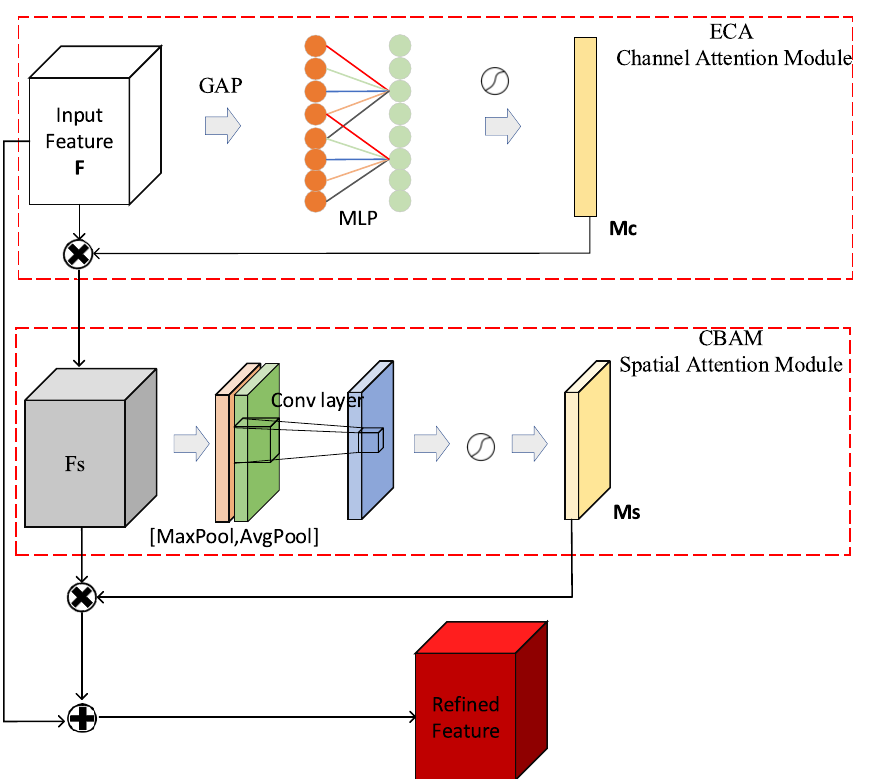
Figure 3. The structure of the attention modules. The attention modules are implemented by com- bining the ECA and the CBAM attention mechanisms. The above part is the ECA attention module which implements the channel attention, and the blow part is the CBAM spatial attention